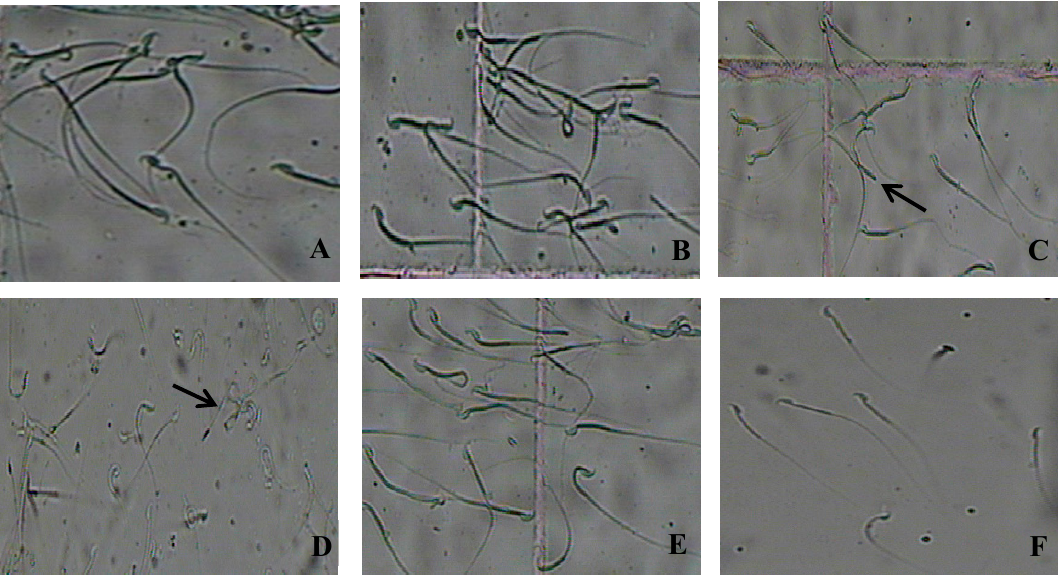
Figure 5. Photographs of mouse sperm showing the types of deformity observed: ( A ) control group, ( B ) detoxifying bacteria group (xy46), ( C ) low-toxicity group (ZEA40), ( D ) high-toxicity group (ZEA70), ( E ) low-toxicity detoxified group (xy46 + ZEA40), and ( F ) high-toxicity detoxified group (xy46 + ZEA70). In ( C ), the arrow highlights sperm that has a head but no hook, a double head, and is amorphous. In ( D ), the arrow shows the tail of a sperm that is becoming folded. The results show that the mice semen has its quality significantly reduced by exposure to ZEA.